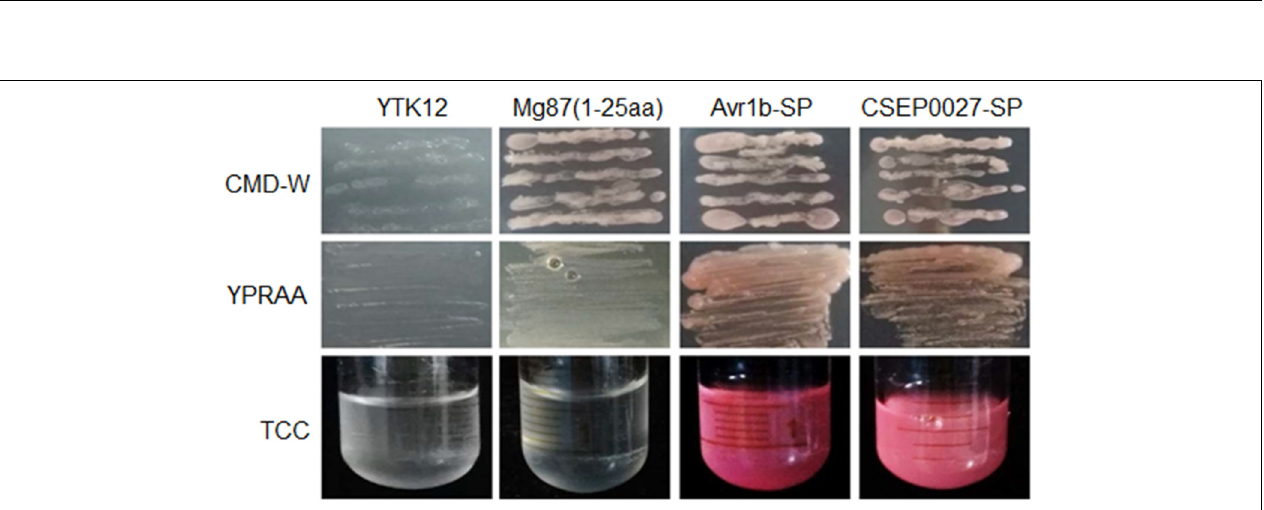
FIGURE 2 | CSEP0027 is a secreted protein. Yeast invertase secretion assay was used to confirm the function of the predicted SP of CSEP0027. A construct expressing a fusion of SP sequence of CSEP0027 and a yeast invertase was transformed into the yeast strain YTK12 and tested in the assay, with the N-terminal sequence of Magnaporthe oryzae Mg87 protein and SP sequence of Phytophthora sojae PsAvr1b used as negative and positive controls, respectively. CMD-W plates were used to select yeast strain YTK12 carrying the pSUC2 vector. YPRAA media were used to indicate invertase secretion. An enzymatic activity test based on the reduction of 2, 3, 5-triphenyltetrazolium chloride (TTC) to red-colored formazan was also used to confirm invertase secretion.